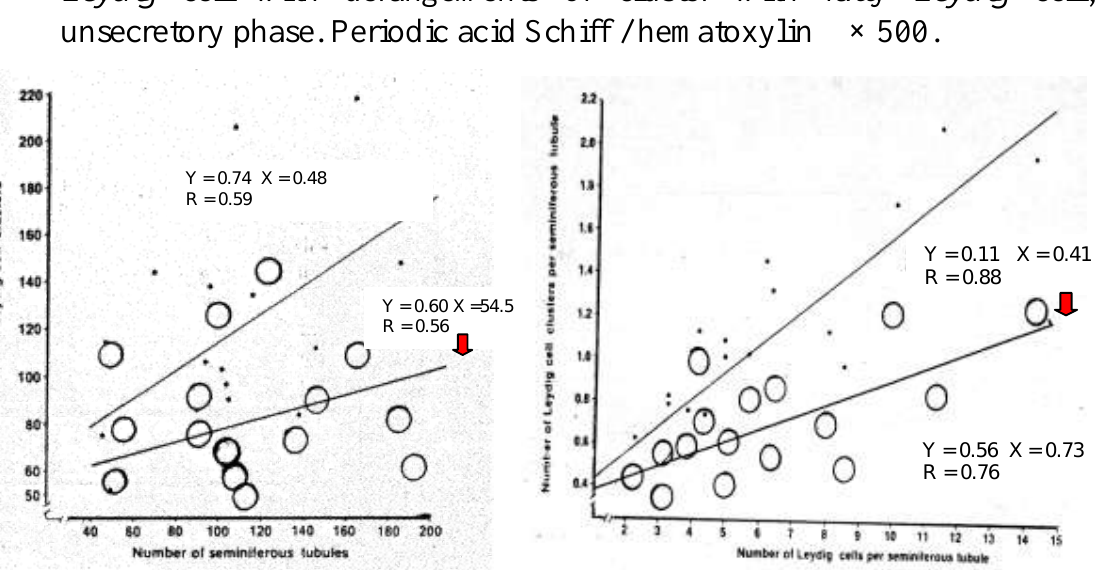
Fig. (1) Correlation of mean number of seminiferous tubules and mean number of Leydig cell clusters for the Gossypol and control groups (P < 0.01).